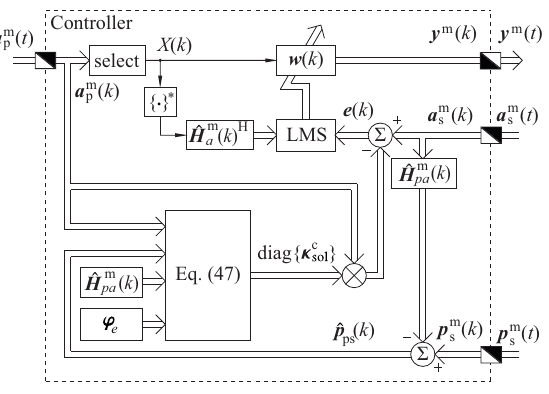
Figure 4: Controller with phase correction for measured inputs.